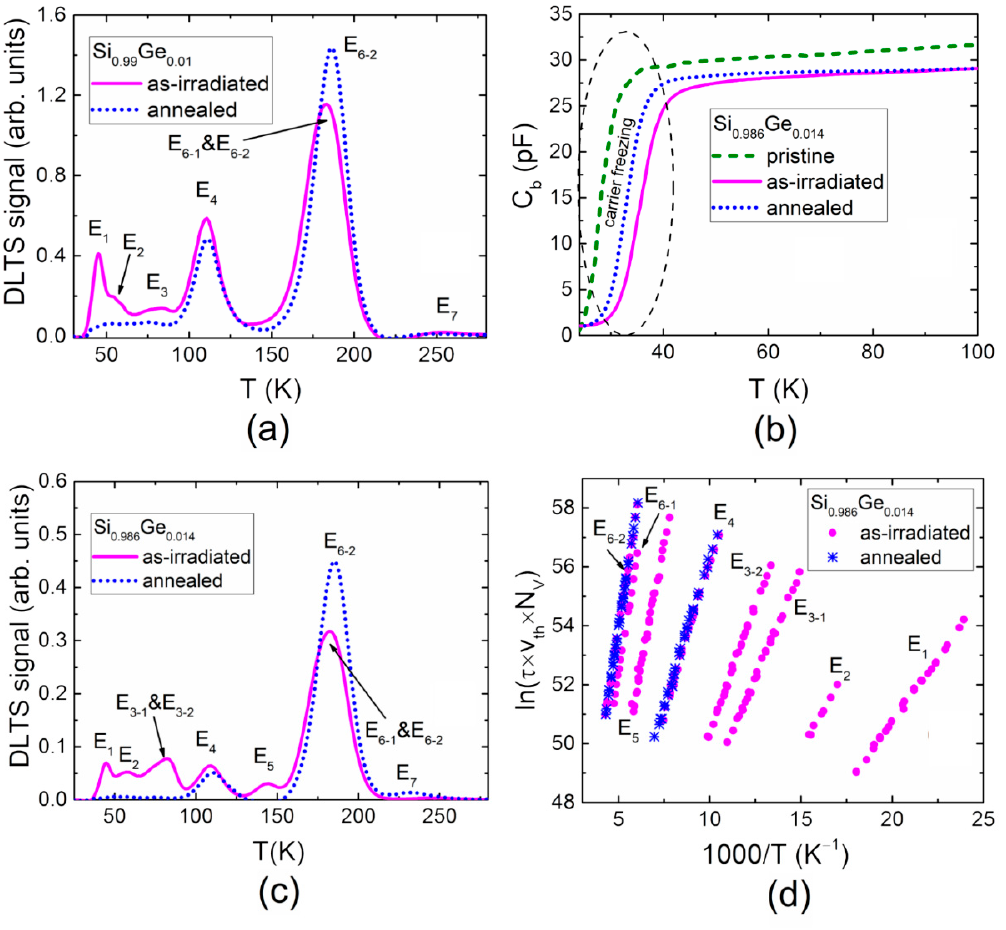
Figure 2. ( a ) DLT spectra recorded on the as-irradiated and annealed Si 0.99 Ge 0.01 diode samples. ( b ) The barrier capacitance dependence on temperature (C b –T) obtained for the pristine, 5.5 MeV electron irradiated and subsequently annealed Si 0.986 Ge 0.014 samples. ( c ) DLT spectra recorded on the as-irradiated and annealed Si 0.986 Ge 0.014 diode samples. ( d ) Arrhenius plots composed for di ff erent Table 2. Summary of traps revealed for the as-irradiated and subsequently annealed SiGe samples with different Ge content.